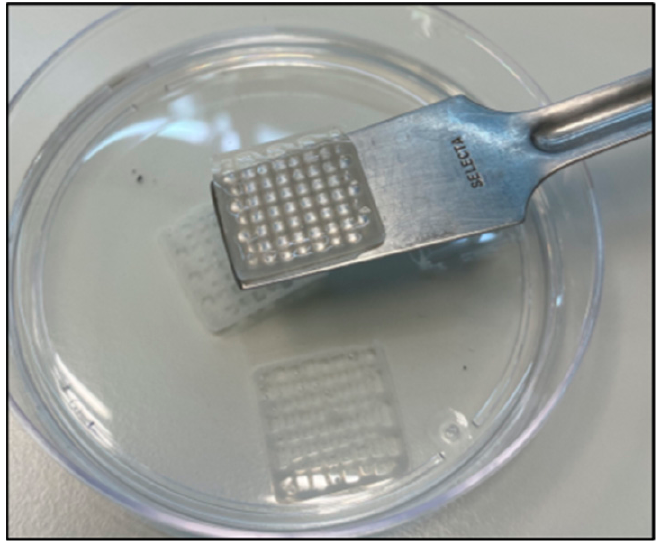
Figure 3. GEL–ALG scaffolds photograph after cross-linking with CaCl 2 .